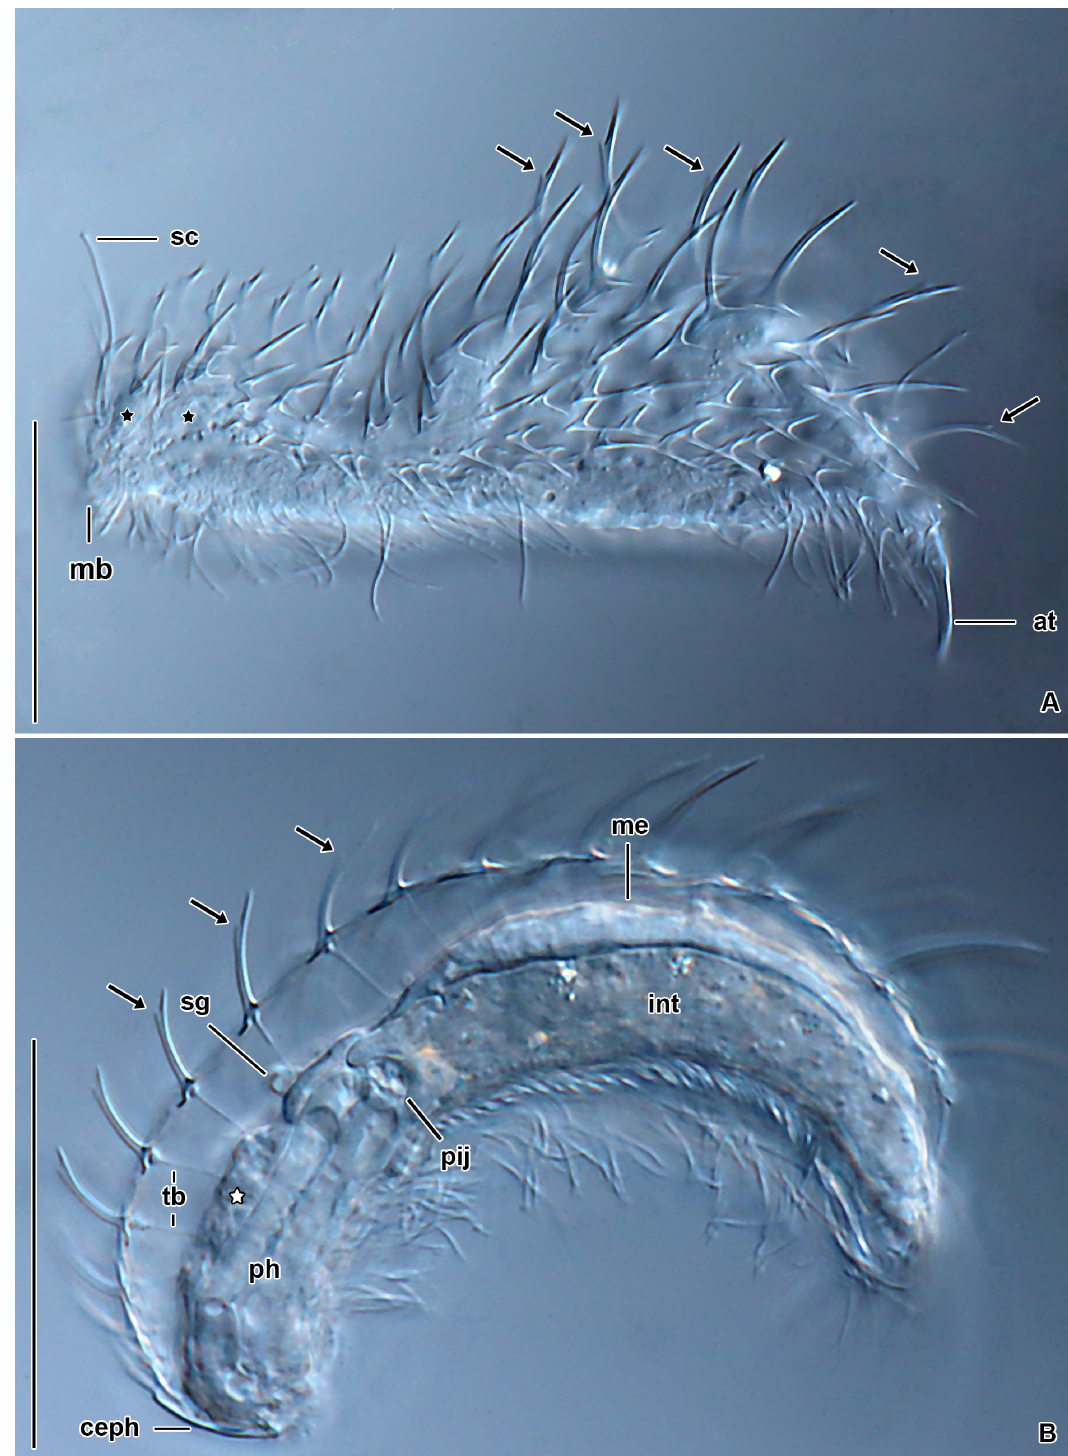
Fig. 16. Chaetonotus ( Hystricochaetonotus ) superbus sp. nov., differential interference contrast. A . Holotype (CU-FNS-15-06-20/HO), lateral overview showing the scale and spine pattern. B . Paratype (CU-FNS-22-06-20/PA), optical section showing the internal morphology in lateral view. Black stars in (A) mark the epipleurae and hypopleurae. White star in (B) marks the cerebral ganglion. Arrows mark the lateral denticle of spines. Scale bars = 30